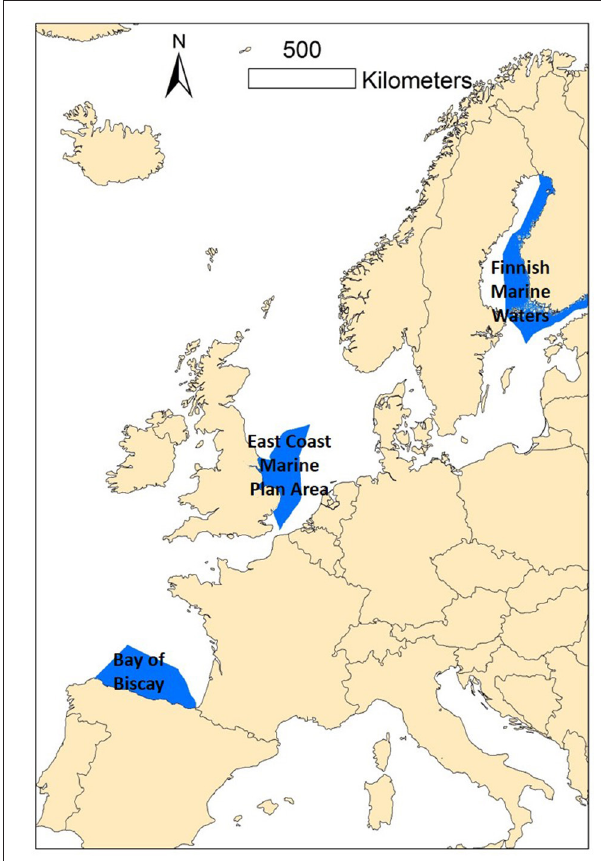
FIGURE 1 | Location of the case study sites.